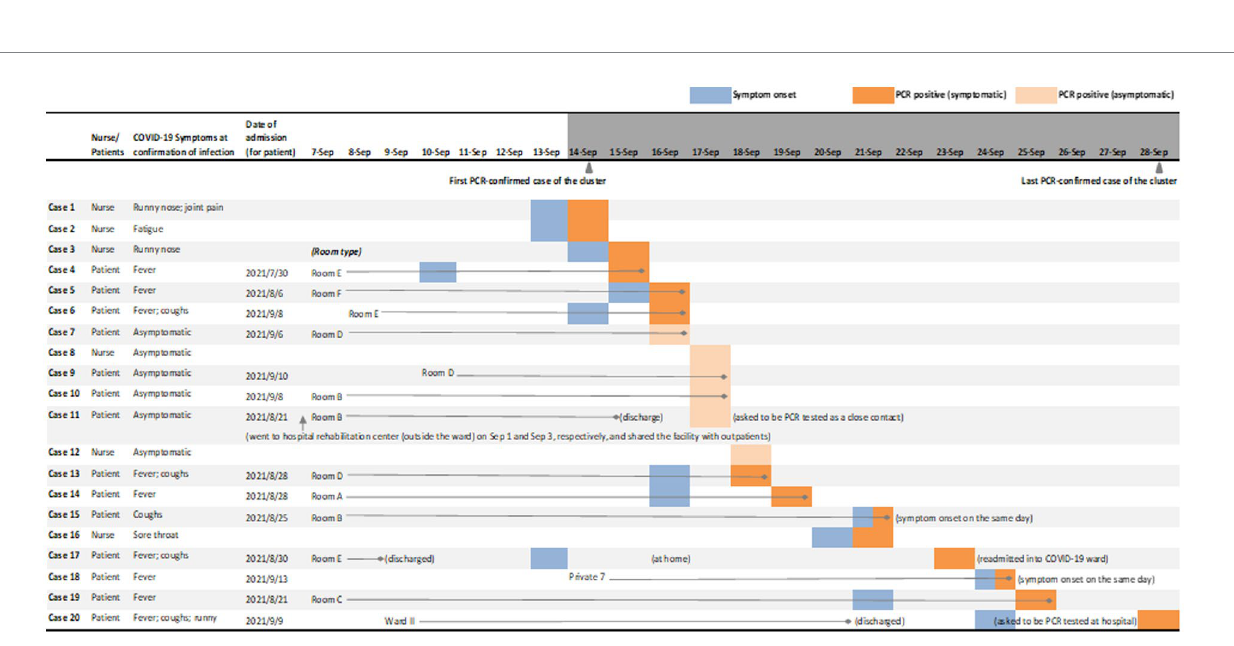
FIGURE 2 Symptoms and PCR-confirmed detection of SARS-CoV-2 infection cases in the nosocomial cluster. This figure shows the PCR-confirmed infected patients’ room type (for inpatients at the timepoint of 1 week prior to the first PCR-confirmed case as September 7, 2021, or their admission date if admitted thereafter), the date of symptom onset and the date of PCR positive test; for infected nurses, date of symptom onset and the date of PCR positive test are shown. Type Room A to F are four-bed shared rooms; along with Private 7, these rooms are all located in Ward I. Case 20 stayed in Ward II of the same floor until discharged on September 21, reported symptoms on September 24, and tested positive on September 28. No other patients in Ward II were detected during the period of the nosocomial cluster. Patients might be transferred during their stay in Ward I due to reasons such as care requirements (for instance, increased proximity to the nurse station); these internal transfers are not shown in this figure. After PCR-confirmed detection, patients were transferred either to COVID-19 wards directly, or to private rooms inside Ward I for temporary stay until transferring to COVID-19 wards; all infected nurses were quarantined immediately after a PCR positive test. Immediately after the first two cases were detected on September 14, 2021, all healthcare workers of Ward I, including doctors, nurses and administrative staff, as well as close contacts, were screened by PCR tests and frequently tested thereafter as new cases were identified in the ward.